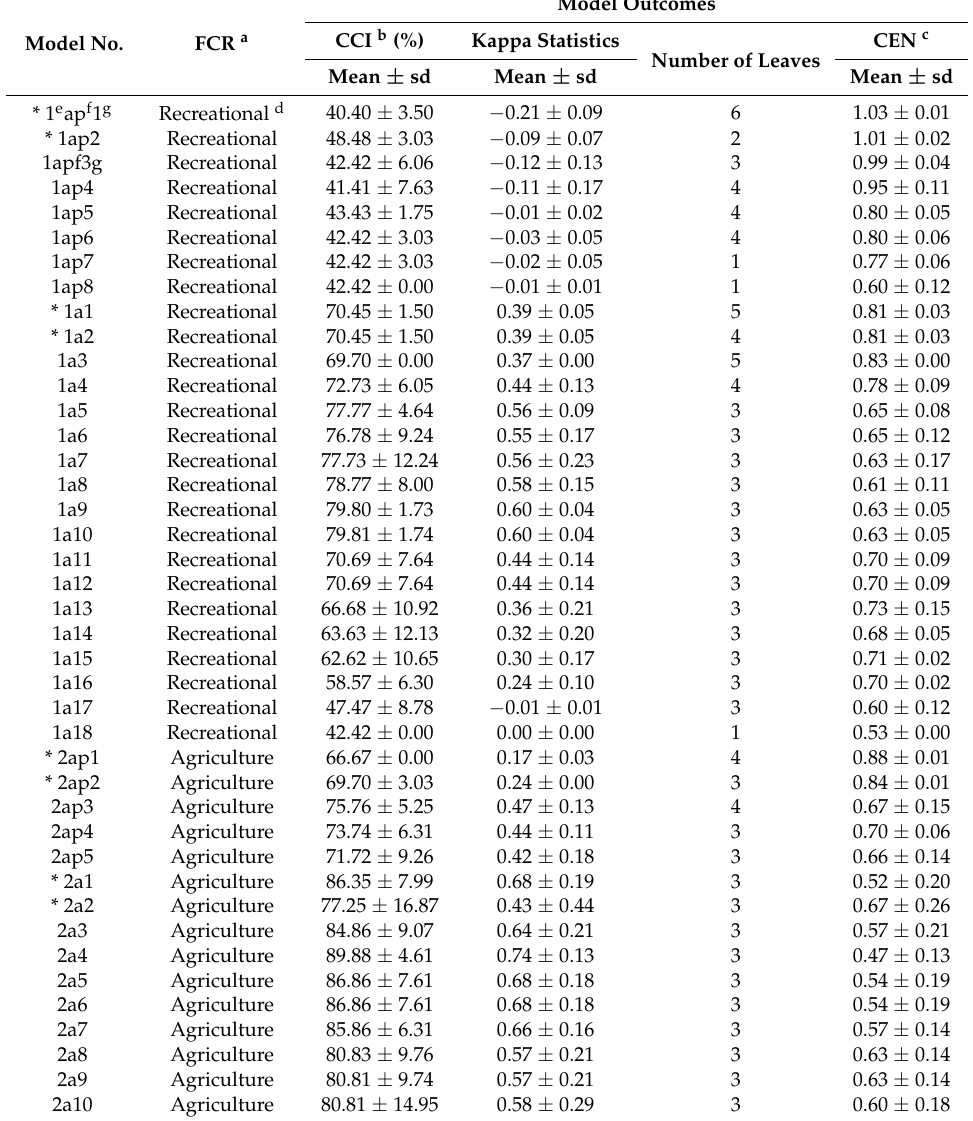
Table A3. Predictable results of the models before and after the optimization process: Correctly classified instances (CCI), Kappa statistics, and overall confusion entropy of a confusion matrix (CEN).